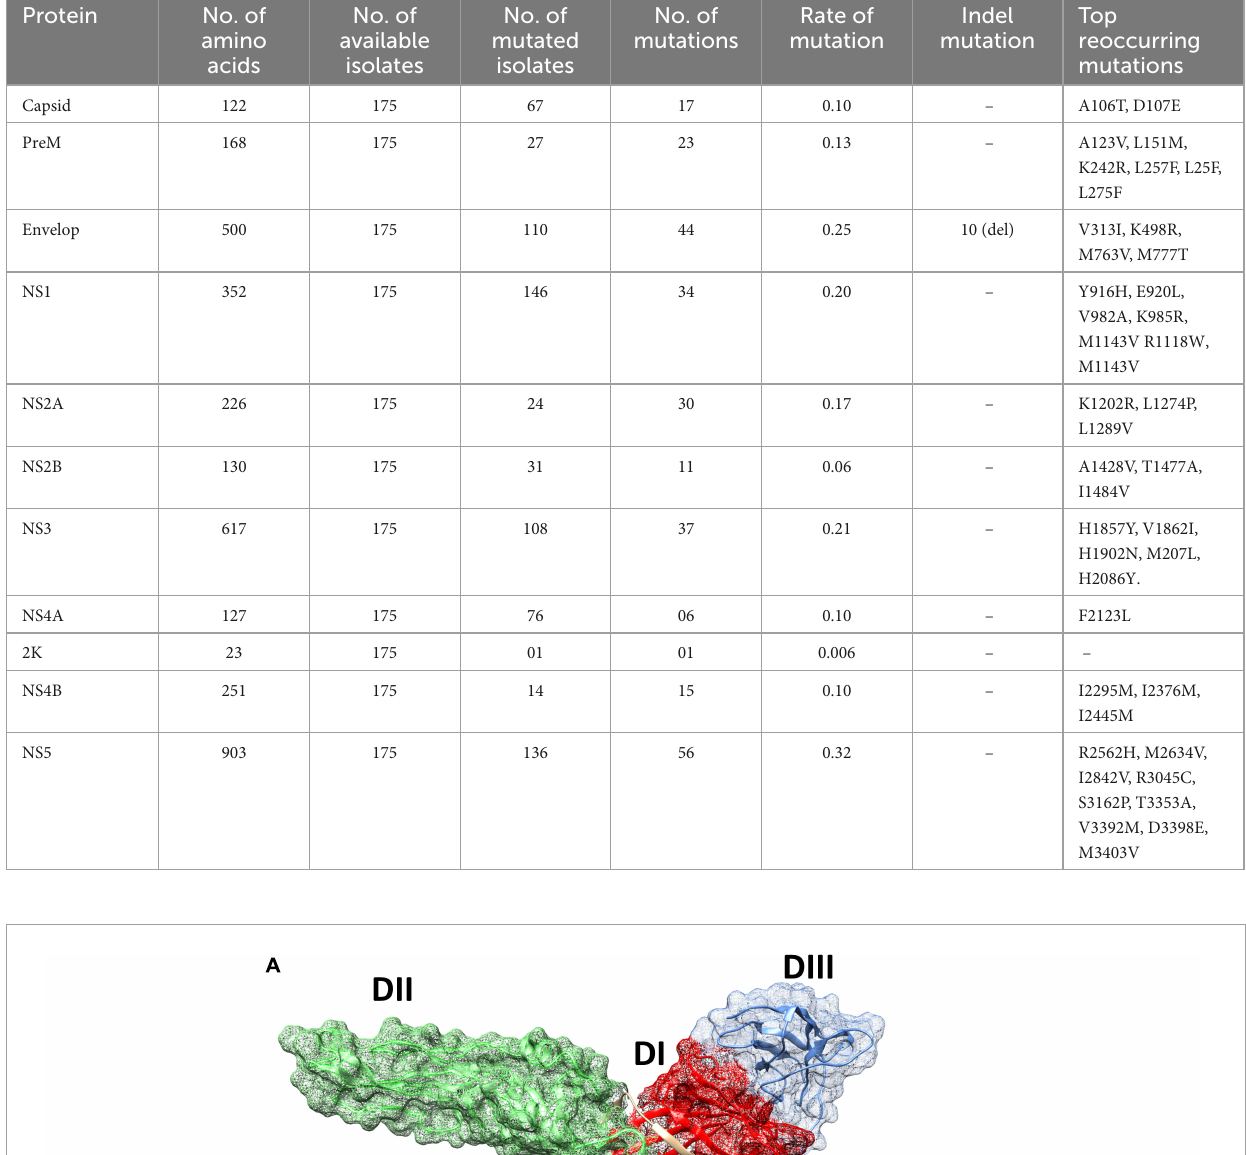
TABLE 1 Summary of mutations in each protein of the ZIKV.